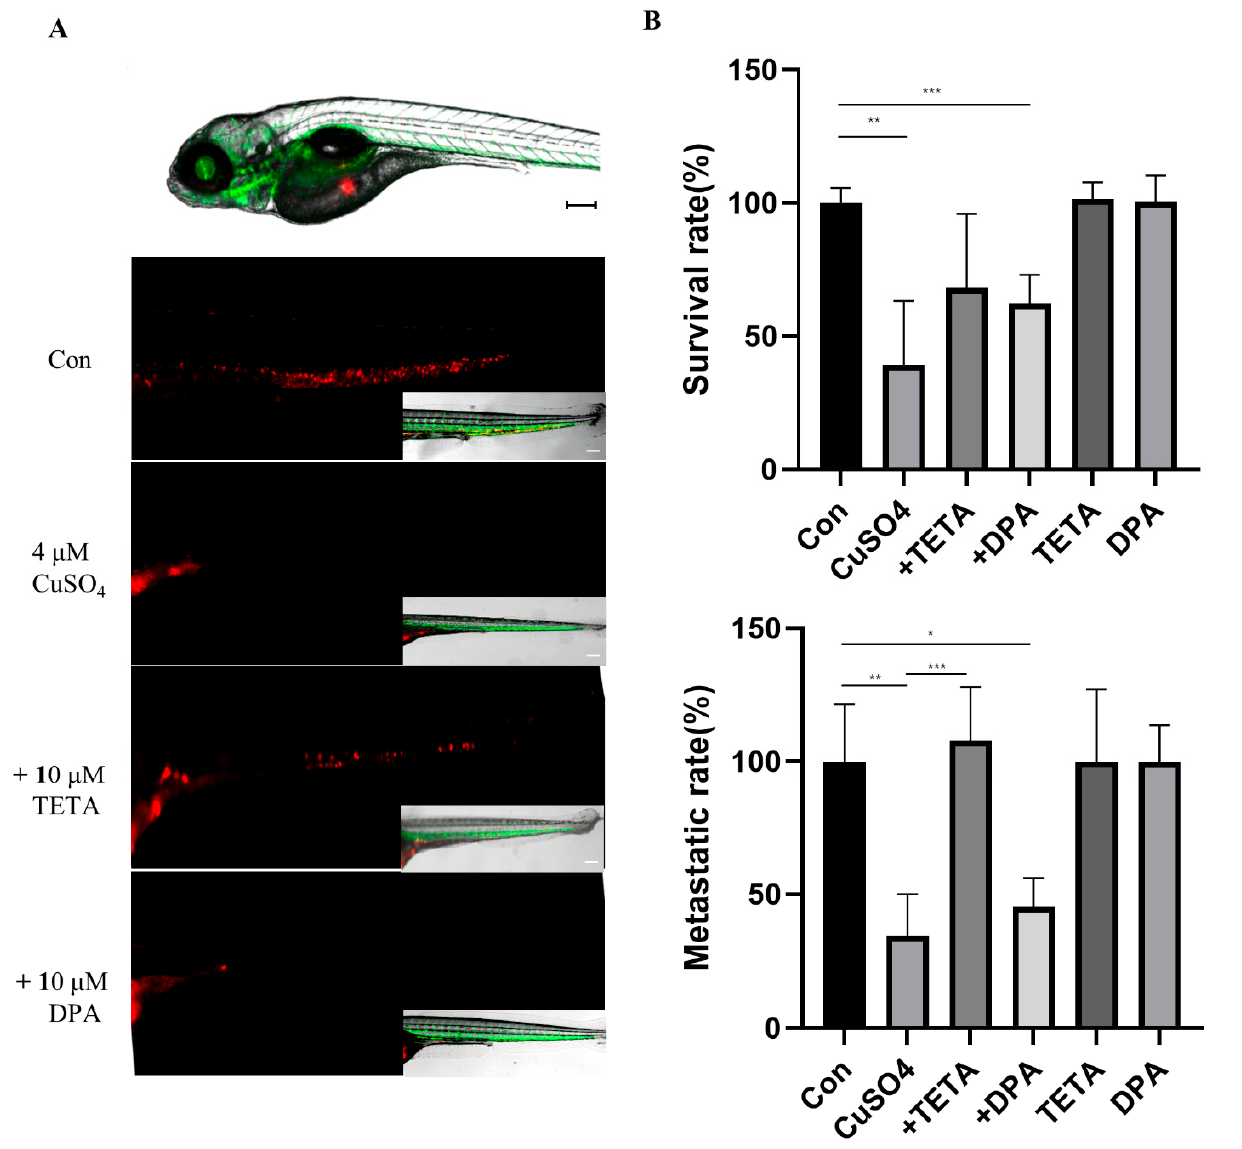
Figure 5. ( A ) Representative images at higher magnification show the invasive U87 cells (red) in the tail region of the embryos via vessels (green). Scale bars: 200 µ m. ( B ) At 5 days post injection, the survival and metastatic rate of Tg (kdrl:EGFP) zebrafish embryos microinjected with CM-DiI U87 cells (n = 50/each group). * p < 0.05, ** p < 0.01, *** p <